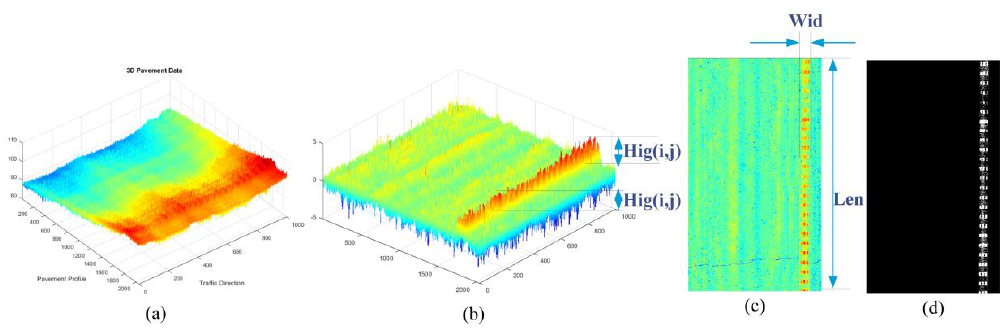
Figure 14. Sparse components and the corresponding road marking information, ( a ) 3D pavement data, ( b ) ( c ) the corresponding sparse components and 3D road marking information, ( d ) road data; ( b , c ) the corresponding sparse components and 3D road marking information; ( d ) road marking information. marking